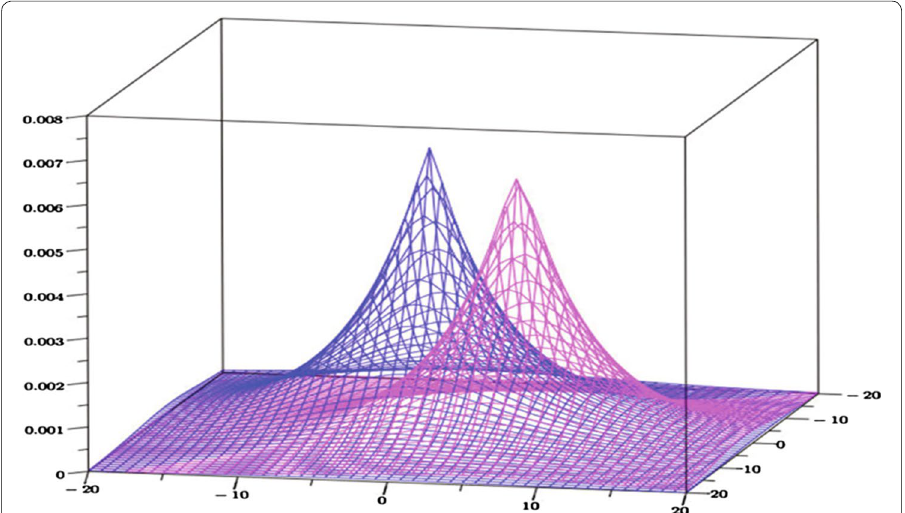
Fig. 8 Probability density functions of two planar Laplacians, centered on the (real) locations ( (5, 3), respectively